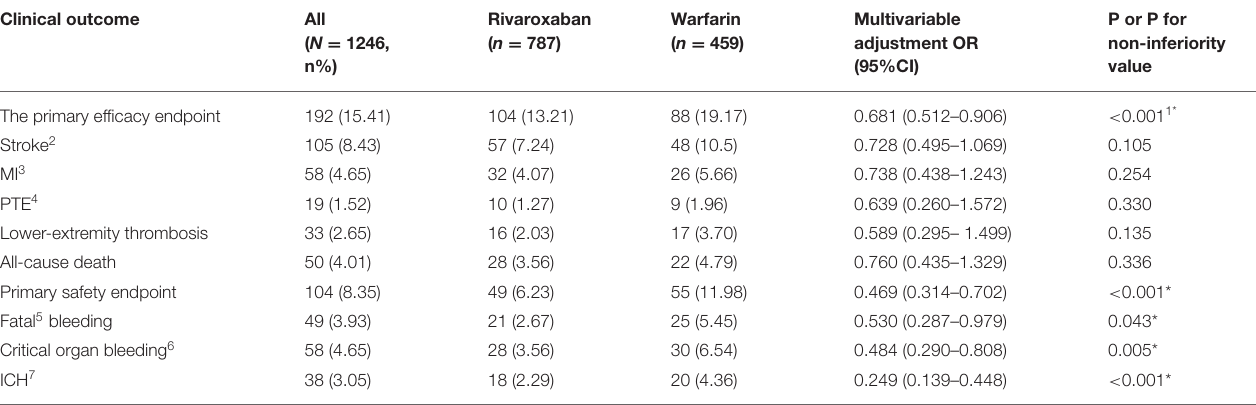
TABLE 2 | Comparison of end point events in the rivaroxaban and warfarin groups. Clinical